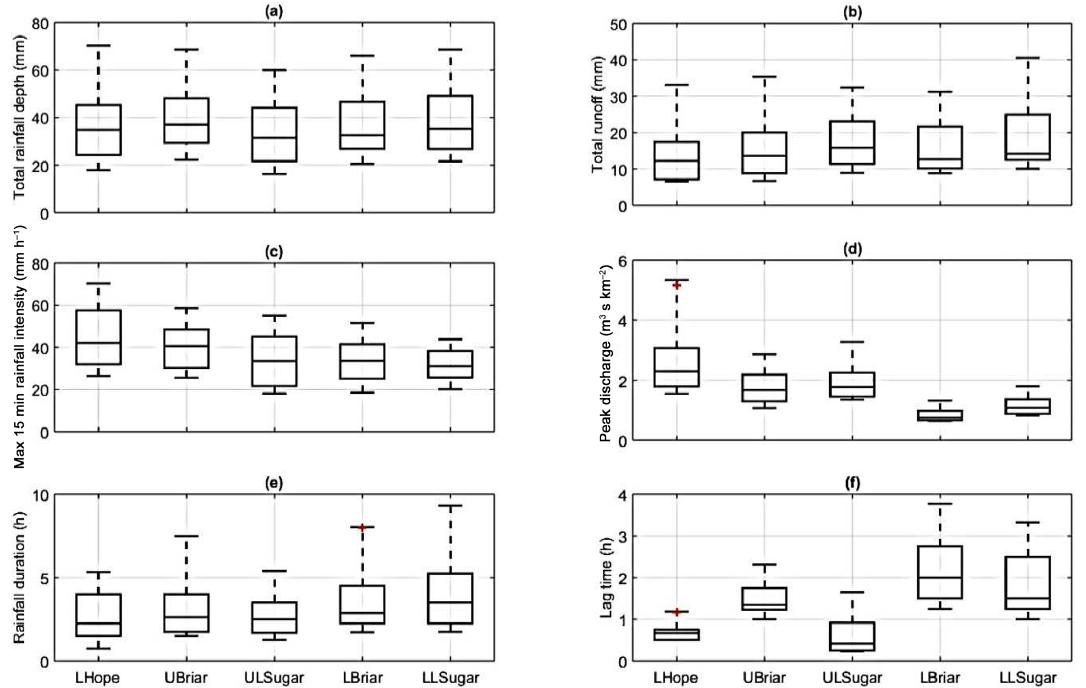
Figure 2. Box plots showing 10, 25, 50, 75 and 90% quantiles of characteristic rainfall and flow values for all events, per basin: total basin- average rainfall depth (a) , total normalized runoff volume (mm) (b) , max 15min rainfall intensities (mmh − 1 ) (c) , normalized peak flows (m 3 s − 1 km − 2 ) (d) , rainfall duration in hours (e) , lag time (f) . Box plots are based on 50 to 69 events per basin, as listed in Table